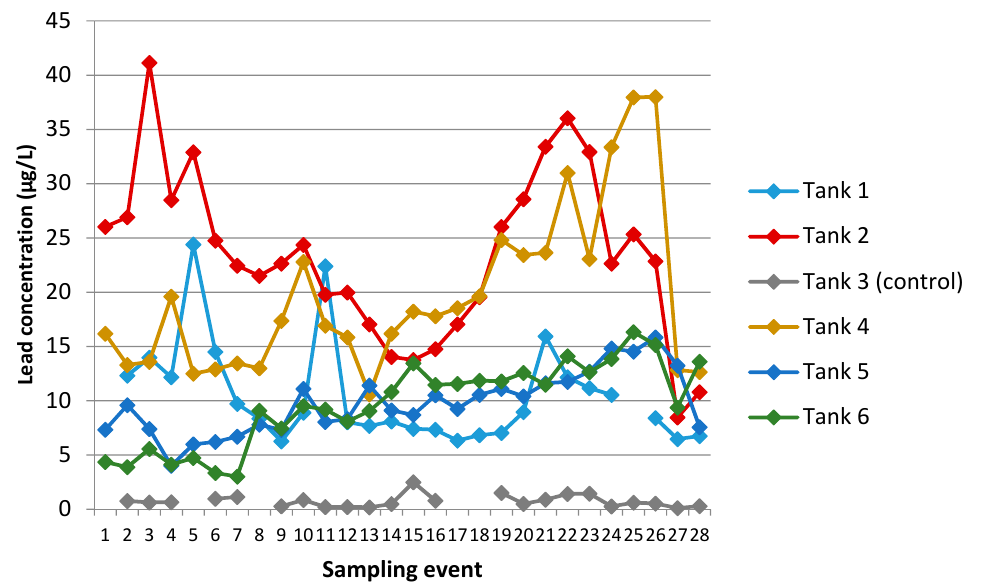
Figure 9. Changes in concentrations of lead over 28 sampling events.